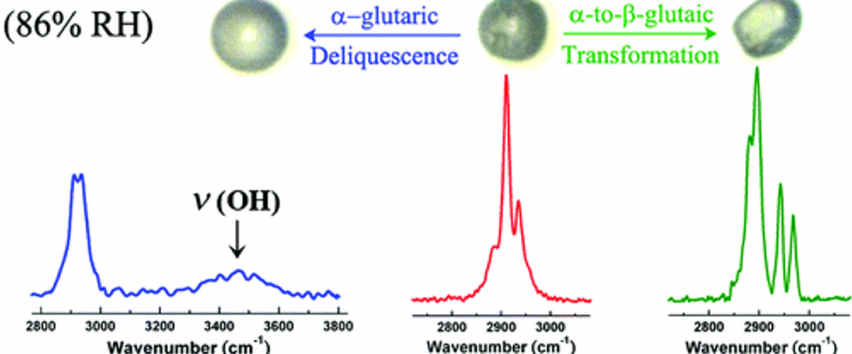
Figure 2. Raman spectra of deliquescent α -glutaric acid, crystalline α -glutaric acid, and β -glutaric acid (Ling and Chan, 2007).